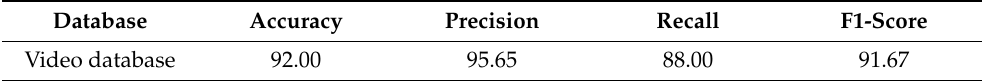
Table 1. Physical violence recognition results on the video database